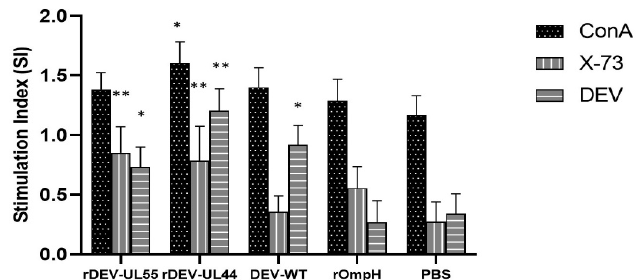
Figure 6. Peripheral blood T-lymphocyte proliferation assays were evaluated by MTT assay at 8 weeks post-immunization. Data are shown as the SI mean ± SD. Statistically significant differences are indicated by (**) p < 0.01 and (*) p < 0.05 compared with the PBS control.